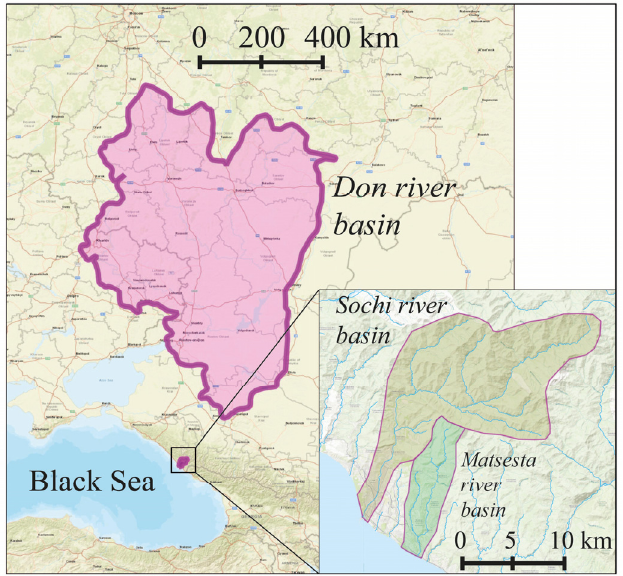
Figure 1. Watershed areas of the Don River (pink area), Sochi River (brown area at the inset), and Matsesta River (green area at the inset).